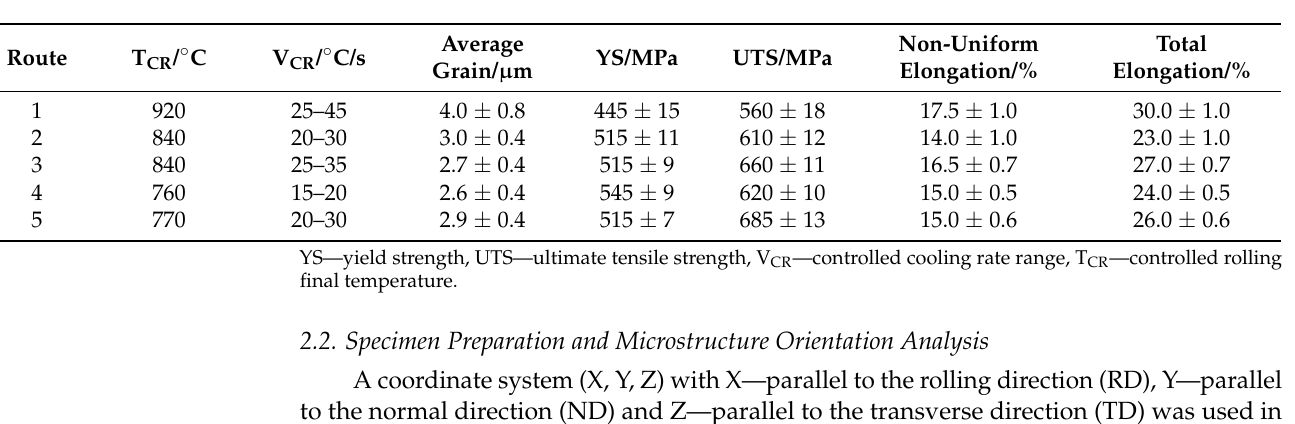
Figure 1. Schematic illustrations of cutting out of specimens for SEM and EBSD ( a ) and of the TMCP routes ( b ). Table 1. Processing parameters, average grain size and tensile mechanical properties for five routes of